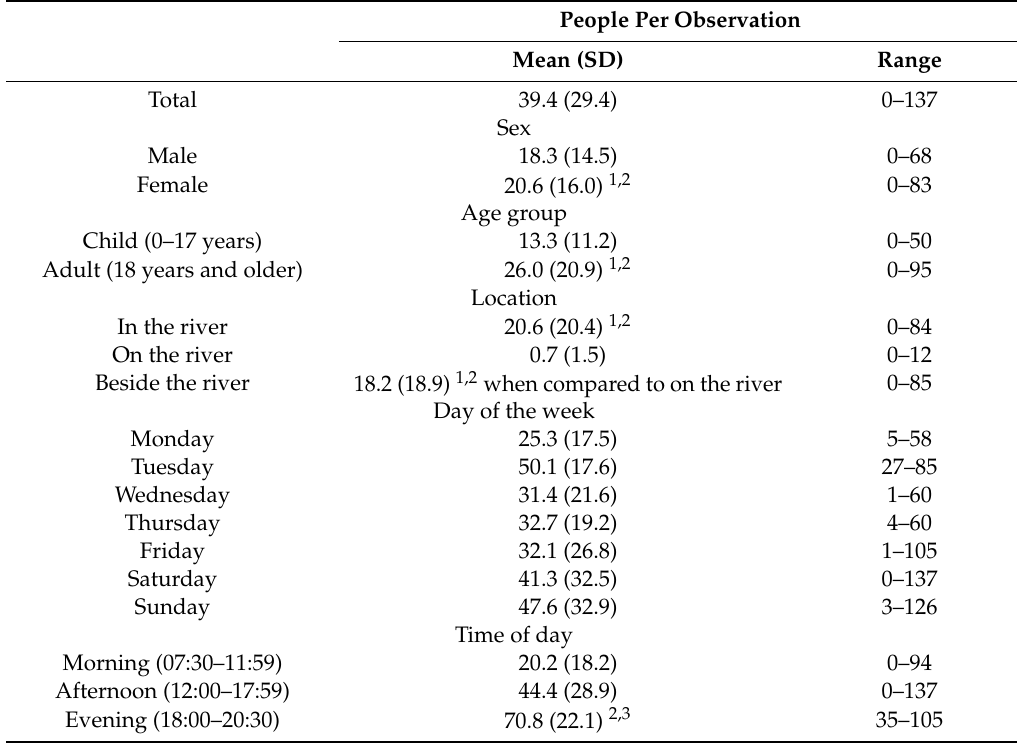
Table 2. Demographics, proximity to river, and day of week by people observed ( n = 290